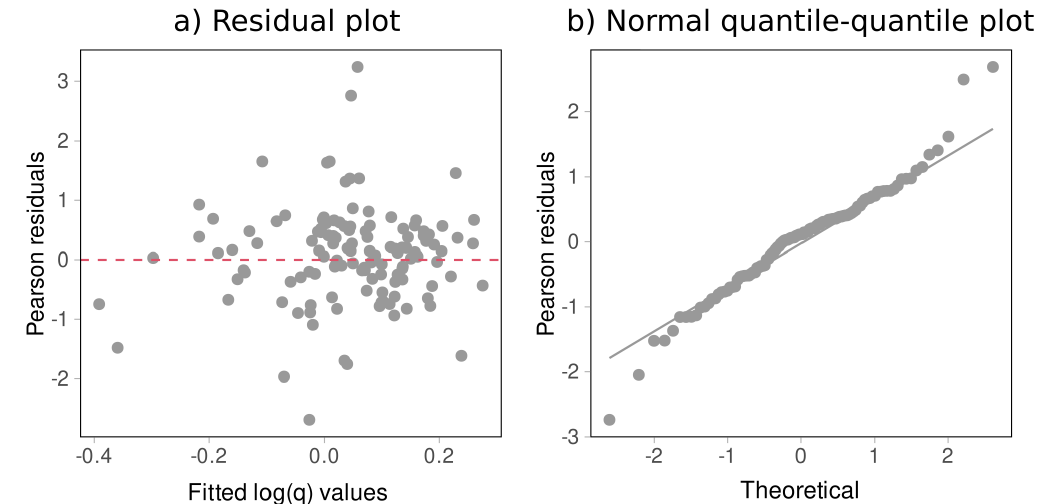
Figure 4. Diagnostic plots for PQI model fitting for COL1 ↵ 1 508-519 indicating a valid statistical model. a) Residual plot between fitted log ( q ) values and Pearson residuals, and b) quantile-quantile plot of residuals wherein the grey line indicates the 1-1 line. Both diagnostic plots indicates that the PQI model is valid except slightly too heavy tails in the normal distribution. 200 randomly selected data points are shown in each plot. Normal quantile-quantile plots compare quantiles of Pearson residuals to quantiles of standard normal distribution. Linearity of the quantile-quantile plot implies that residuals are normally distributed as proposed in the Parchment Glutamine Index (PQI) model. With the exception of a few data points on both tails of the quantile-quantile plots, the model fits the deamidation well (Figure 5). The few data points that do not fall onto the quantile-quantile line for peptides COL1 ↵ 2 756-789 and COL1 ↵ 2 756-789’ (see Figure 5) is the result of a low S/N that affects the correct estimation of q values from the MALDI-TOF